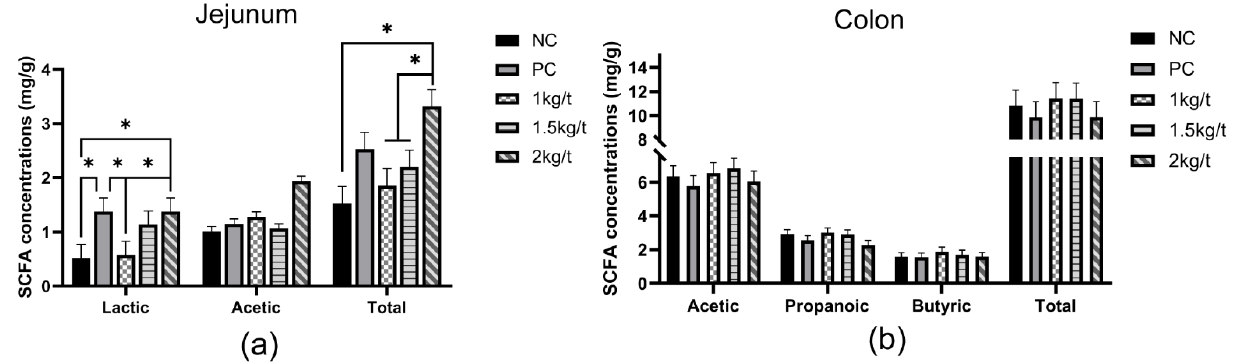
Figure 5. Effects of joint application of Lactobacillus Plantarum and Bacillus subtilis on intestinal lactic acid and SCFAs concentrations in weaned piglets. ( a ) Lactic acid and SCFA content in the jejunal digesta. ( b ) SCFAs content in the colonic digesta. “*” means there were statically significant differences ( p < 0.05). NC, a control diet; PC, NC + 150 ppm mucilage sulfate. Note: Propionic acid and butyric acid were not detected in jejunal digesta, and lactic acid was not detected in colonic digesta.